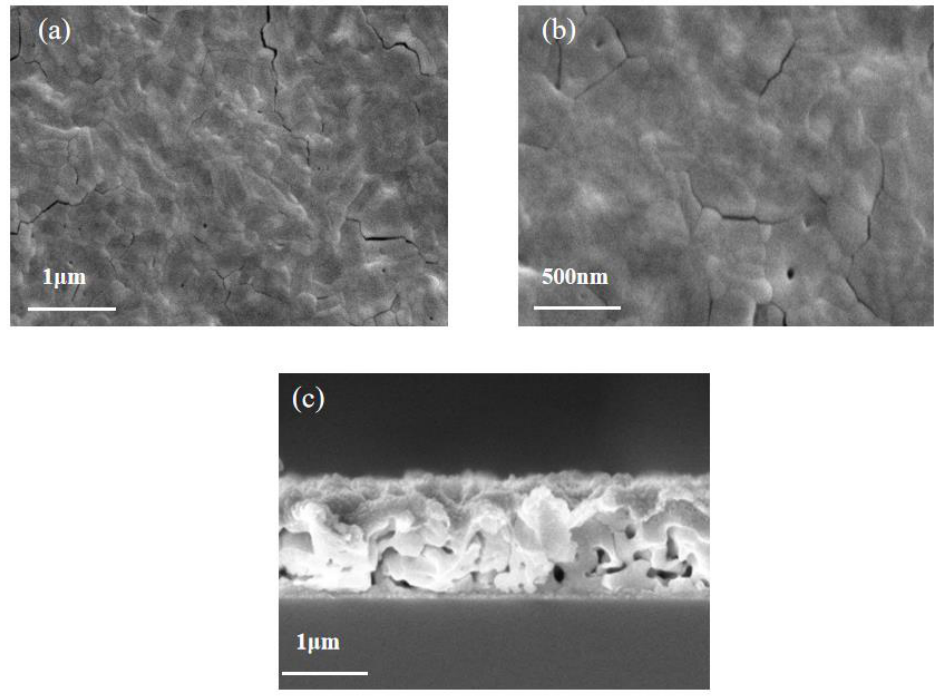
Figure 1. SEM images of HDA-BiI 5 layer ( a ) top view, ( b ) enlarged view, ( c ) cross-sectional view.